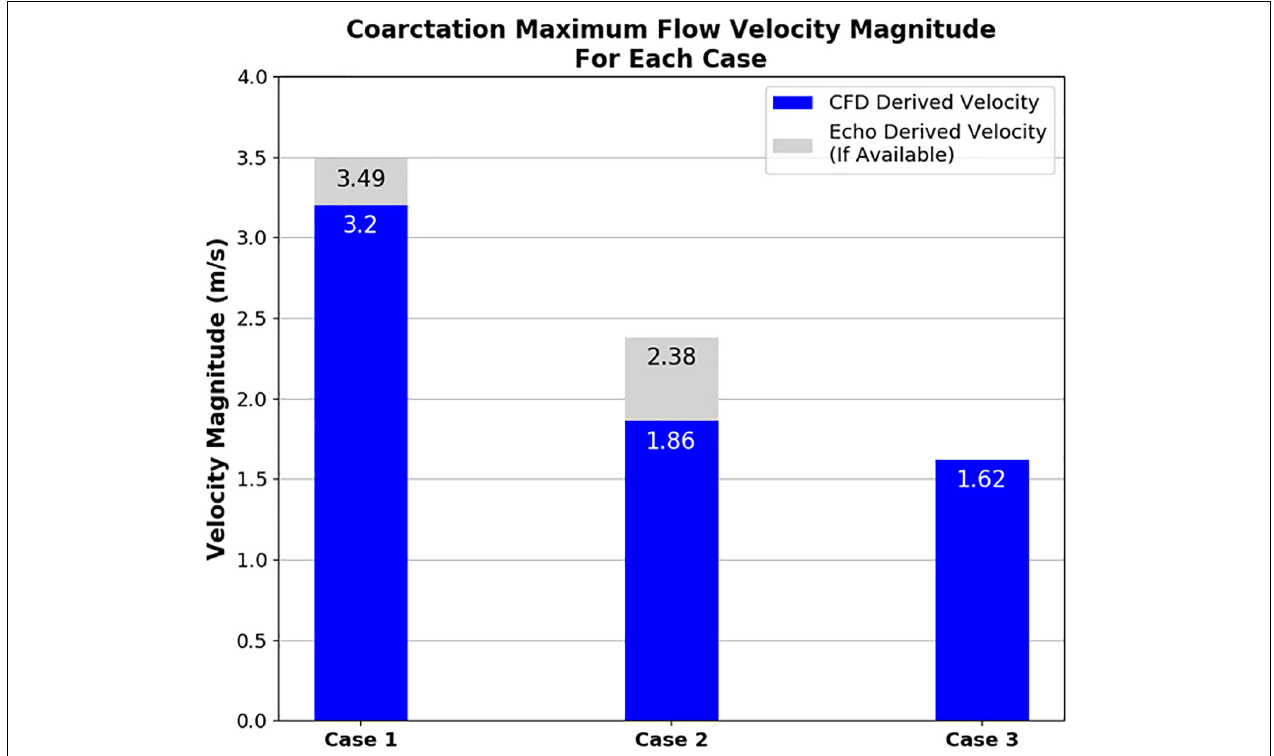
FIGURE 8 | Plot showing the maximum velocity through the coarctation derived from CFD in comparison to echocardiography measurements for each case of coarctation repair. Note that echocardiography data was not available for case